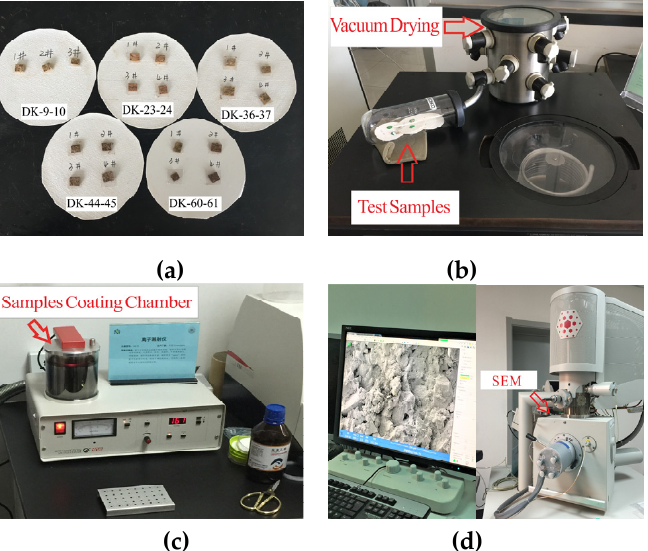
Figure 1. The main test procedures of the microstructure scanning samples. ( a ) Sample preparation; ( b ) freeze-drying; ( c ) surface coating; ( d ) scanning electron microscopy.